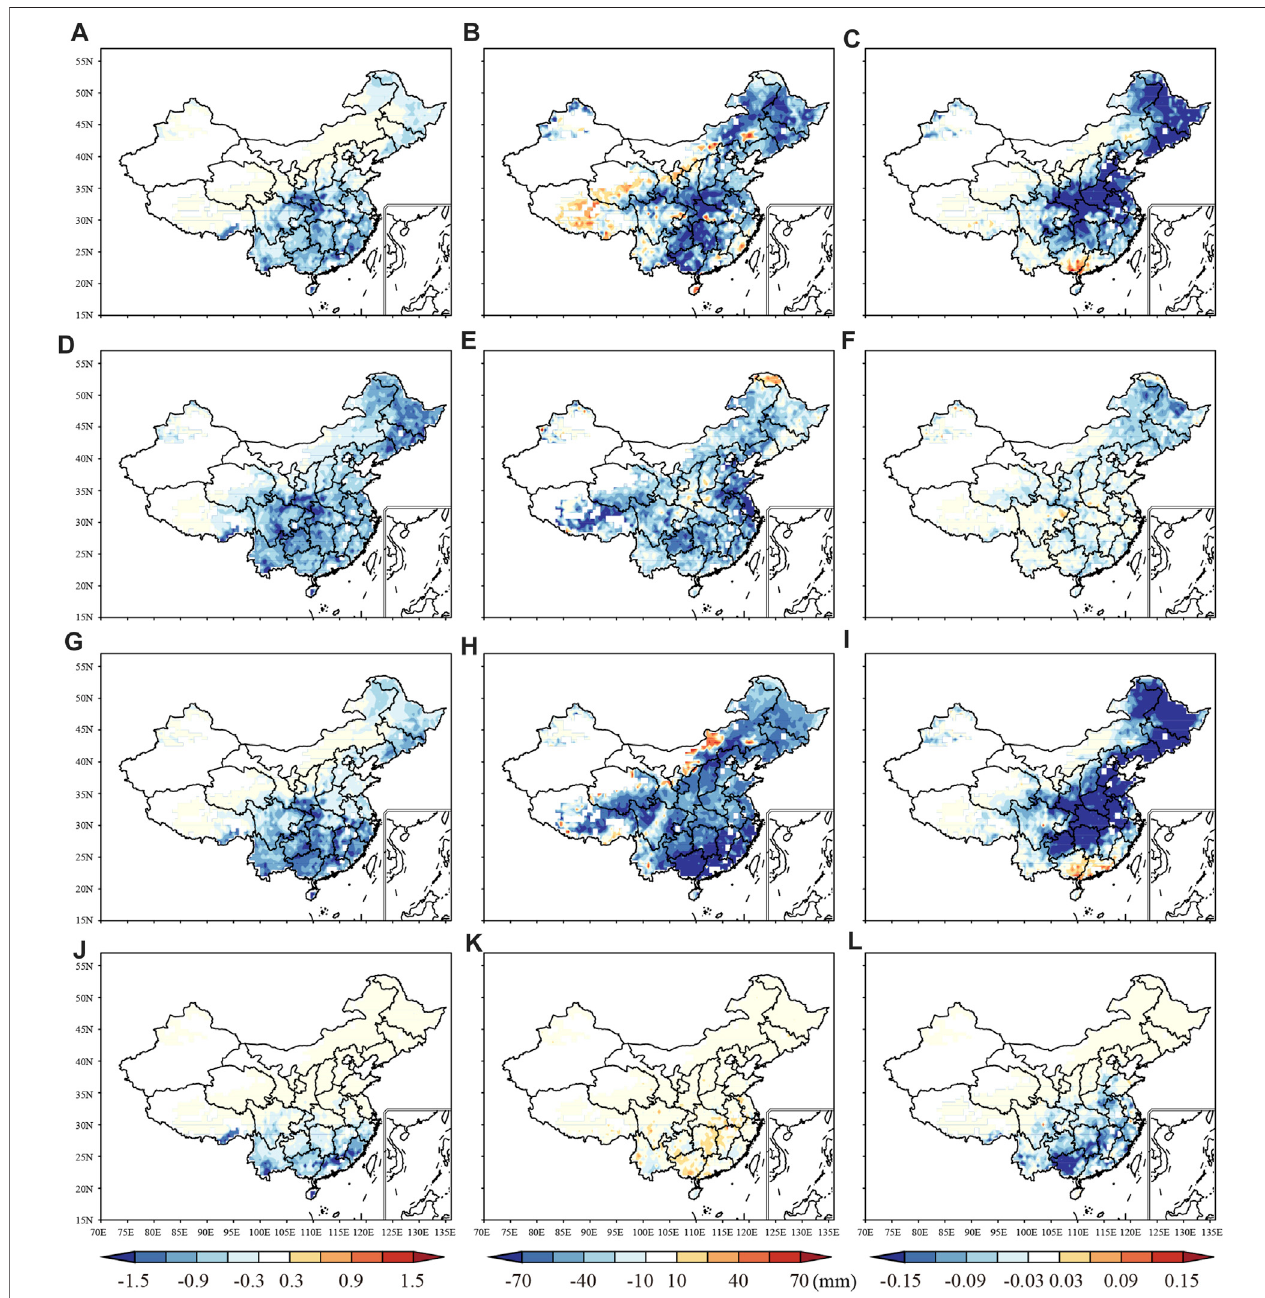
FIGURE 6 | Spatial distribution of negative anomalies in LAI, ET, and T/ET. The fi rst column is LAI, the second is ET, and the third is T/ET. Spring (A – C) summer (D – F) autumn (G – I) and winter (J – L) .